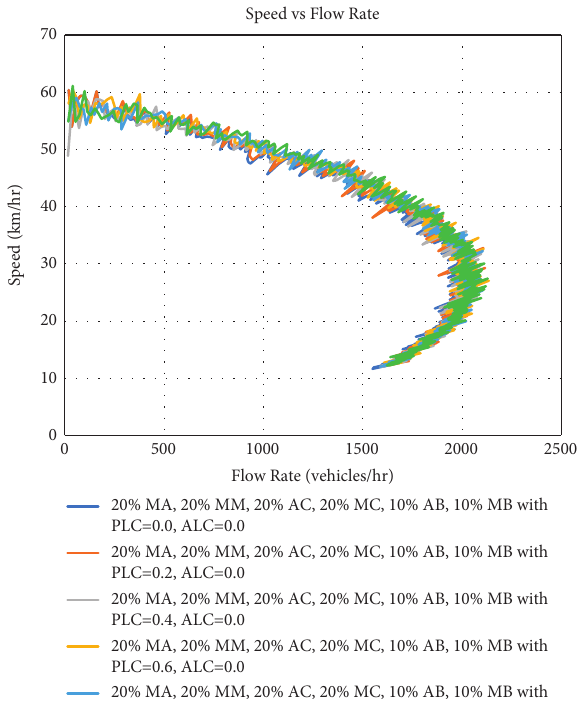
Figure 7: Speed vs. flow rate fundamental diagrams for different compositions of MA, MM, AC, MC, AB, and MB with different values of PLC when ALC is fixed at 0.